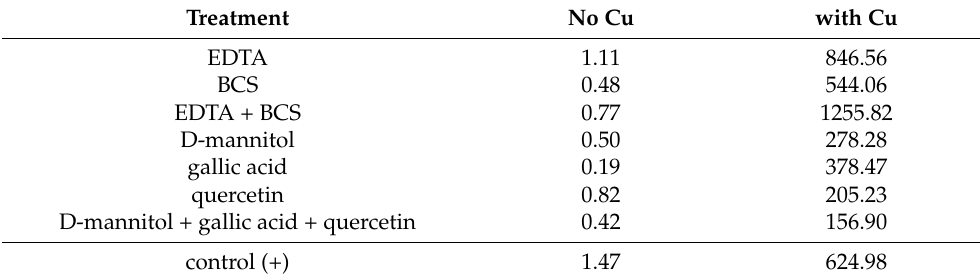
Table 2. Copper concentration (mg mL − 1 ) determined by AAS in milk artificially contaminated with MAP before (No Cu) and after (With Cu) the challenge with copper ions for 30 min for each treatment.